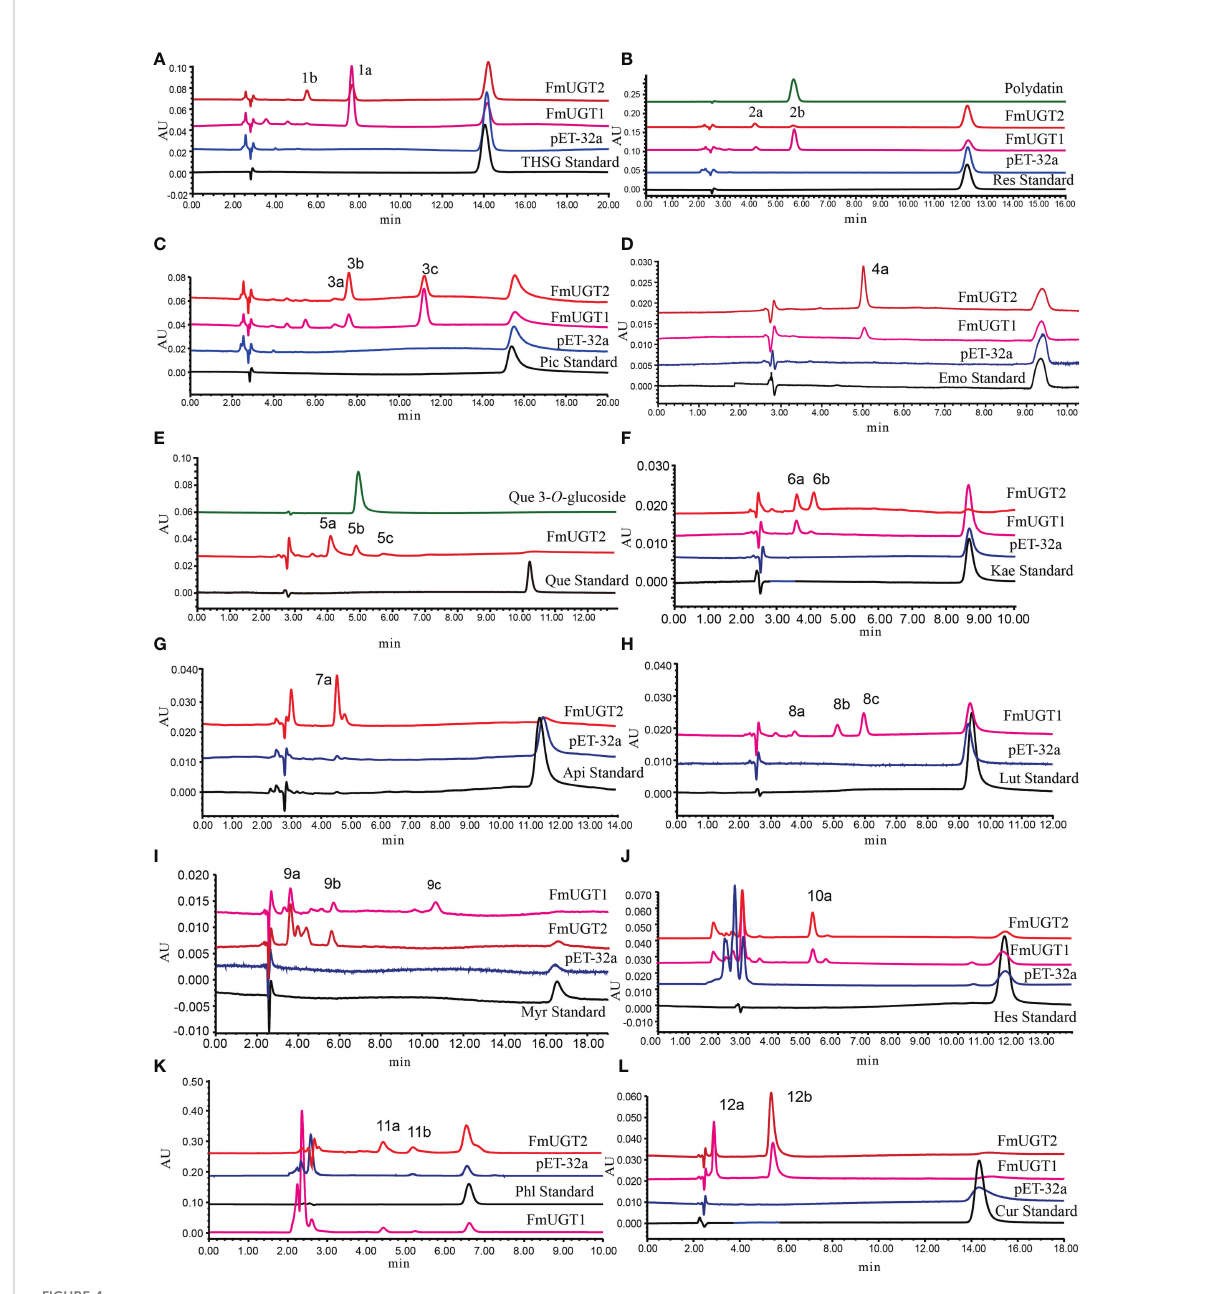
FIGURE 4 Functional assays of FmUGT1 and FmUGT2 using UDP-glucose as the donor and a range of substrates. The reaction mixtures were incubated at 30°C for 12 h. (A) THSG; (B) Resveratrol (Res); (C) Piceatannol (Pic); (D) Emodin (Emo); (E) Quercetin (Que); (F) Kaempferol (Kae); (G) Apigenin (Api); (H) Luteolin (Lut); (I) Myricetin (Myr); (J) Hesperetin (Hes); (K) Phloretin (Phl); (L) Curcumin